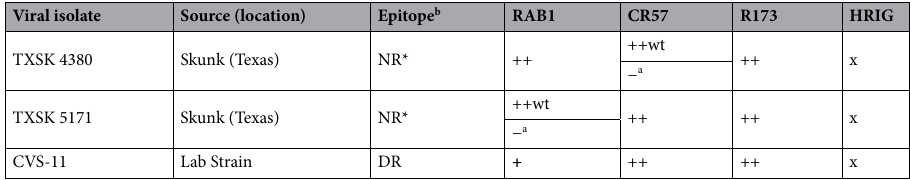
Table 4. RFFIT of RAB1, CR57 and R173 against North America terrestrial isolates. ++EC 50 < 1 µg/mL. + EC 50 ≥ 1 µg /mL. − Not neutralized by HuMAb at the highest concentration tested. x Neutralized by HRIG. a Lab-acquired mutation following additional cell culture passage. A primary wild type (wt) isolate was tested. b RAB1 epitope variants with the noted residues at positions 336, and 346.